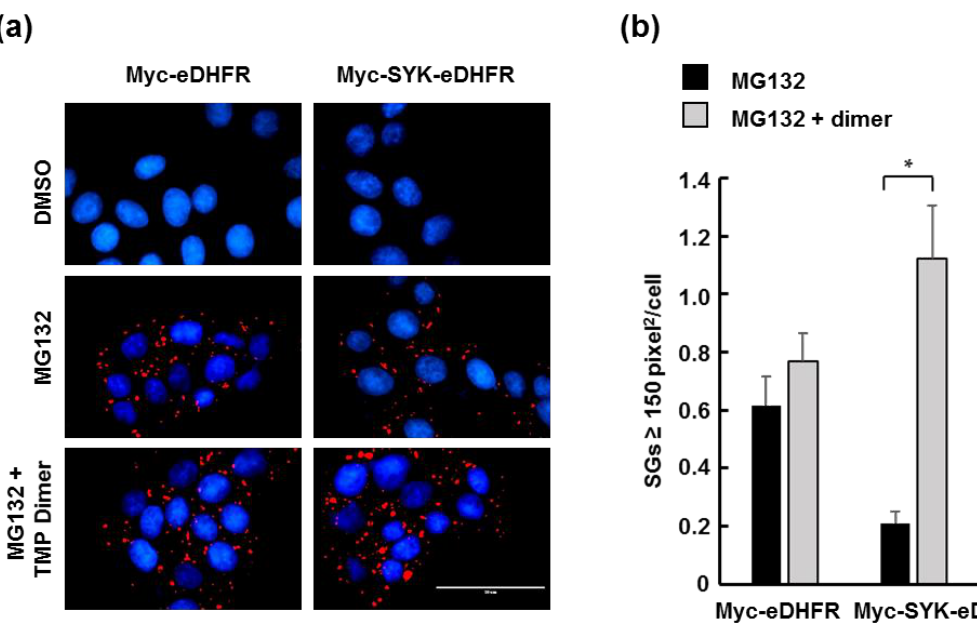
Figure 3. The size of cellular ribonuclear protein aggregates increased when SYK and trimethoprim (TMP) dimerizing agent were present. ( a ) MCF7-BD cells stably expressing Myc-eDHFR or Myc-SYK-eDHFR were treated with or without MG132 to induce the formation of SGs in the presence or absence of TMP dimer. Cells were fixed and stained with antibodies against G3BP (red) and stained with 4’,6- diamidino-2-phenylindole (DAPI) to visualize nuclei (blue). Bar, 50 μm; ( b ) Large stress granules (SGs) were counted in cells treated as described in panel a. The histogram represents average ± standard error of the mean (SEM) of 80–100 cells from experiments repeated three times. * p < 0.05. DMSO, dimethylsulfoxide.